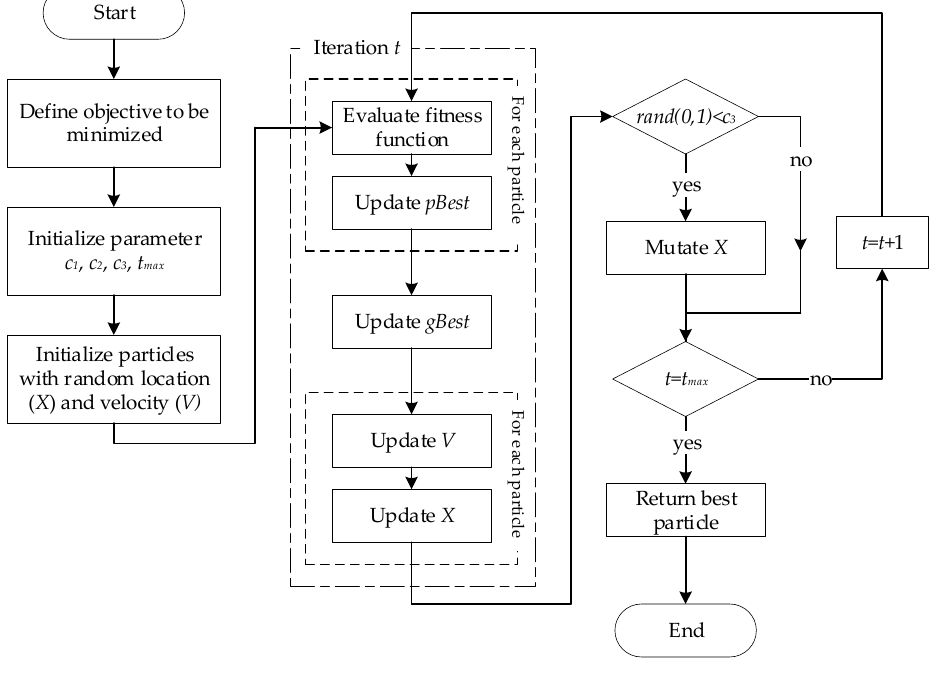
Figure 3. Workflow of PSO algorithm.